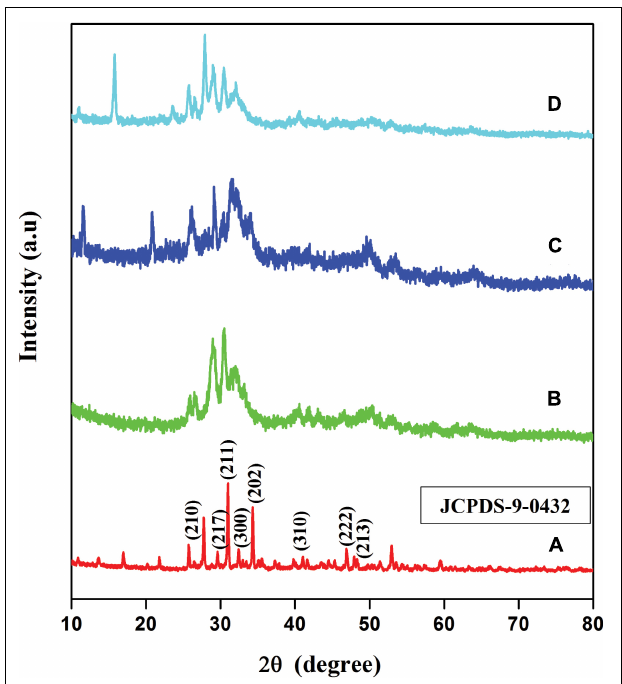
FIGURE 2 | The XRD patterns of (A) HA, (B) BM-HA, (C) BM-HA/PAA, and (D) BM-HA/PAA/UMB